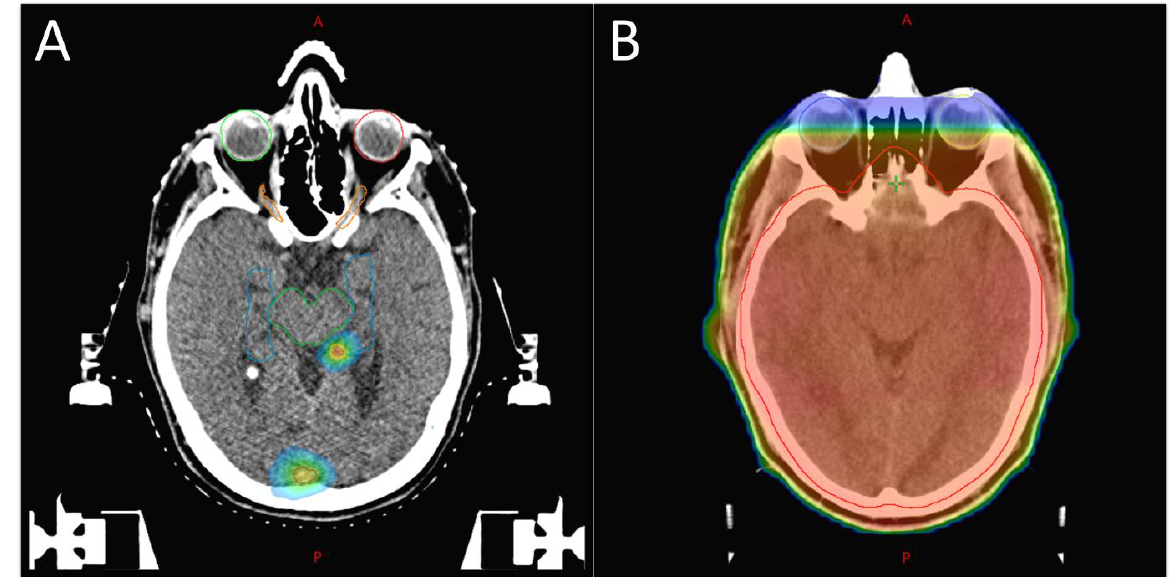
Figure 1. Examples of treatment plans for ( A ) SRT and ( B ) WBRT. Shown are isodose distribution in color wash display (dose fall of from red to blue). ( A ) SRT of two brain lesions with a step dose fall off. Organ at risk delineation with brain stem (green), hippocampus (blue), optic nerves (orange) and eye cavity (light green and red). ( B ) WBRT without hippocampal avoidance. Target volume brain (red).